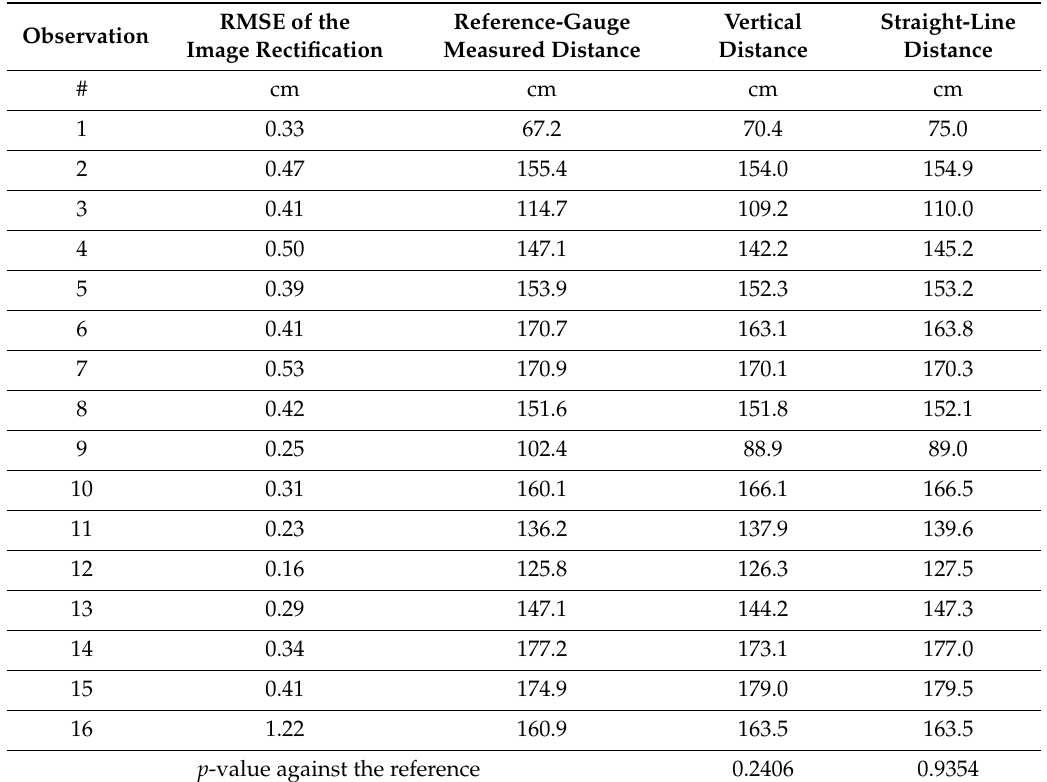
Table 1. Summary of the image rectification root square mean error (RMSE), measurements, and calculated